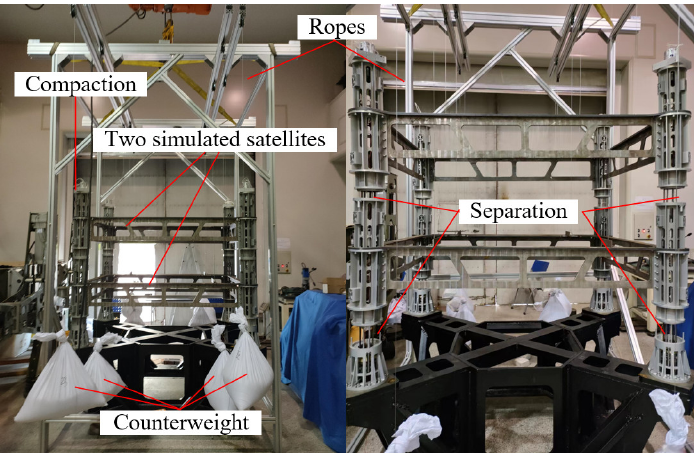
Figure 18. Unlocking function experiment.